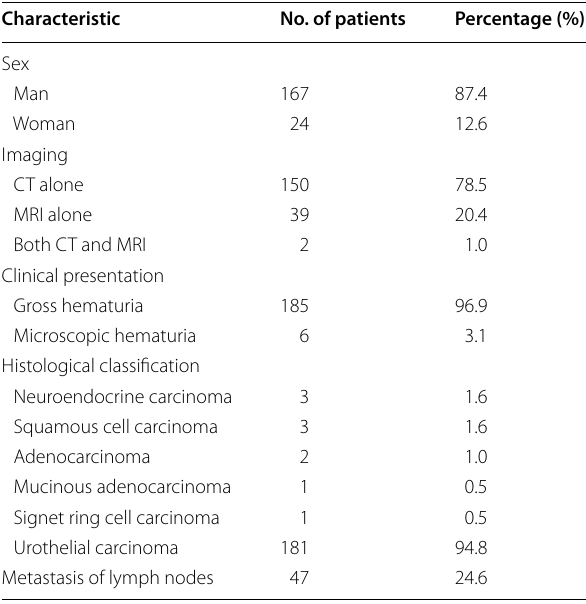
Table 1 Baseline demographic and clinical characteristics of 191 patients with bladder cancer who underwent radi-